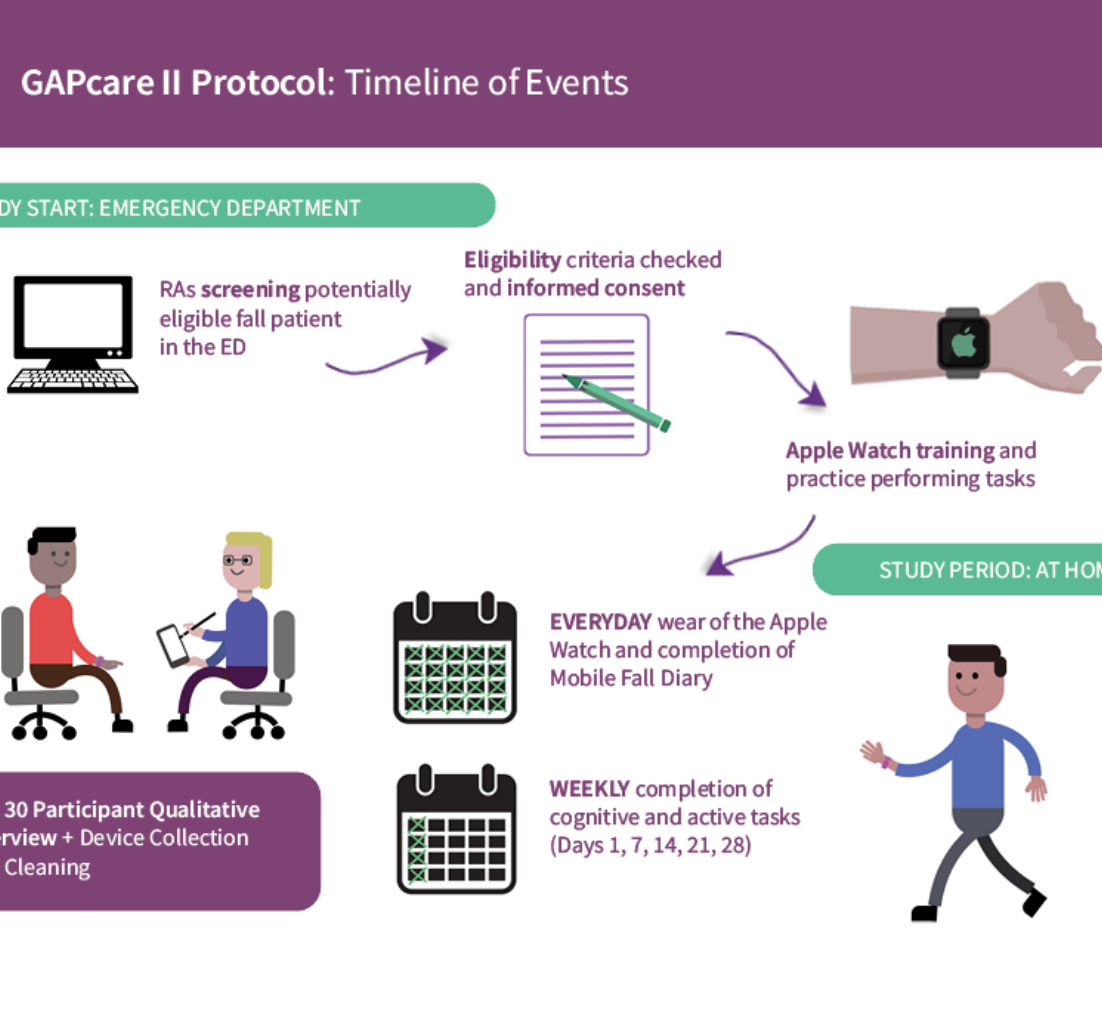
Figure 1. Timeline of study duration. ED: emergency department; GAPcare II: Geriatric Acute and Post-Acute Fall Prevention Intervention II; RA: research